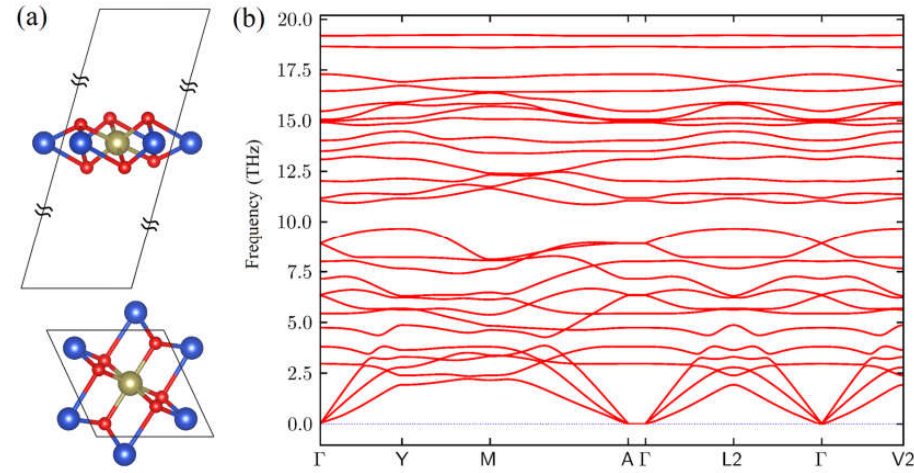
Figure 1. The atomic structure of the unit cell ( a ) and phonon dispersion curve ( b ) for the Cu 2 TeO 6 monolayer.